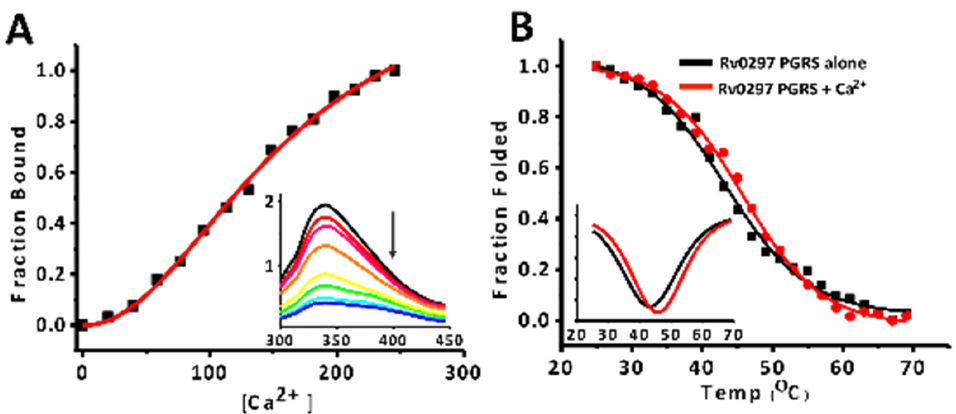
Figure 3. Fluorescence titrations and thermal shift assay. ( A ) Nonlinear curve fit of fluorescence emission maximum to determine Kd for Rv0297PGRS with Ca 2+. Inset shows fluorescence emission spectra (300–450 nm) of each titration of protein with increasing concentration of Ca 2+ . ( B ) Non-linear curve fitting analysis of fluorescence-based thermal shift assays to determine melting temperature (Tm) of Rv0297PGRS alone (Black) and in presence of Ca 2+ (Red). Insets show first derivative of respective Tm curves.